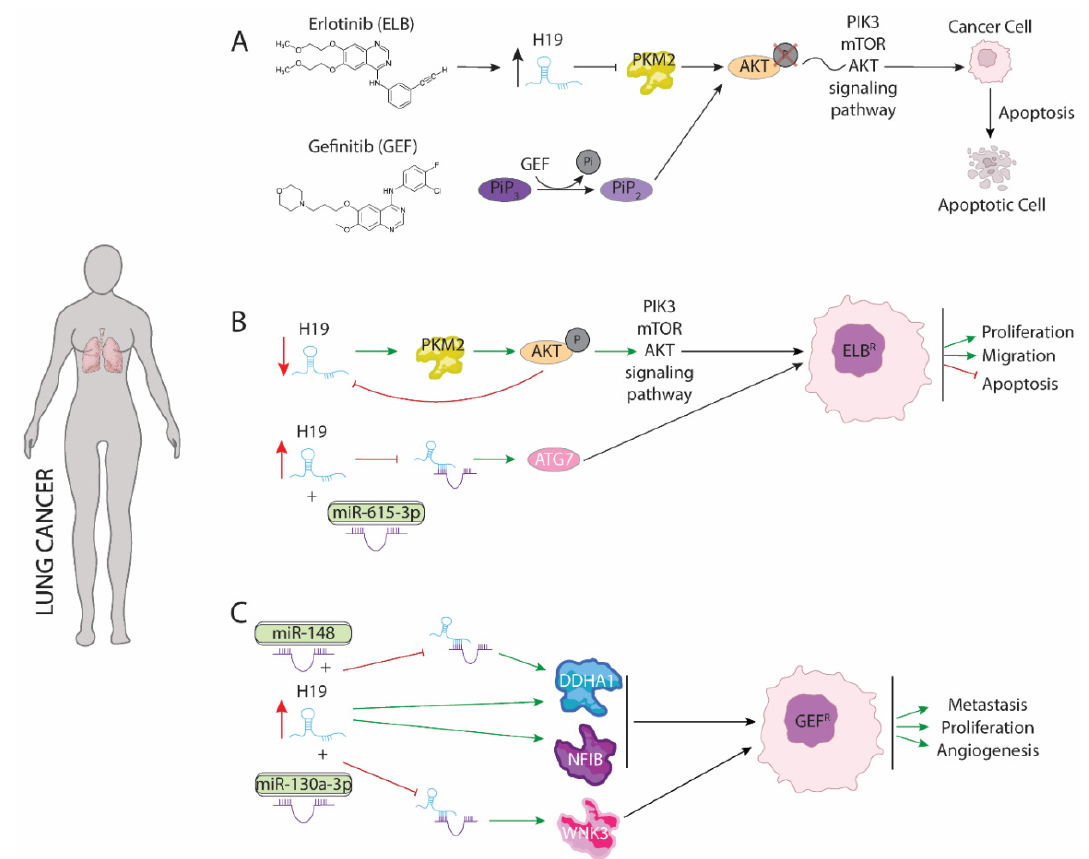
Figure 2. Schematic representation of molecular mechanism dependent of H19 function in lung cancer. ( A ) Modes of action of Erlotinib (ELB) and Gefinitib (GEF) drugs involved in lung cancer treatment. ( B ) Dual role of H19 in acquired resistance to Erlotinib modulating PKM2 and ATG7 proteins. ( C ) Role of H19 as a sponge to binding miR-148 and miR-130a enhancing expression of DDHA1, NFIB and WNK3 proteins increasing proliferation, metastasis, and angiogenesis procedures.